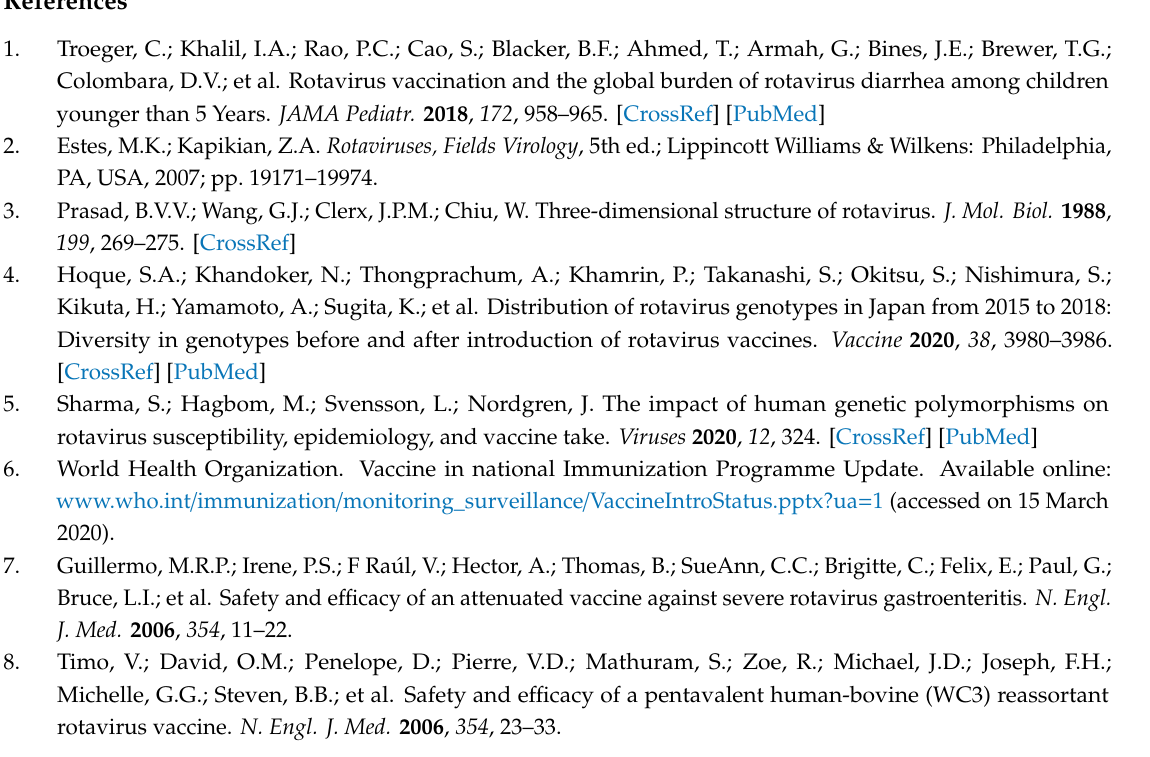
Table S1: RVA G1 VP7 strains analyzed in this study. Table S2: Geographical and temporal information of strains in lineage I and